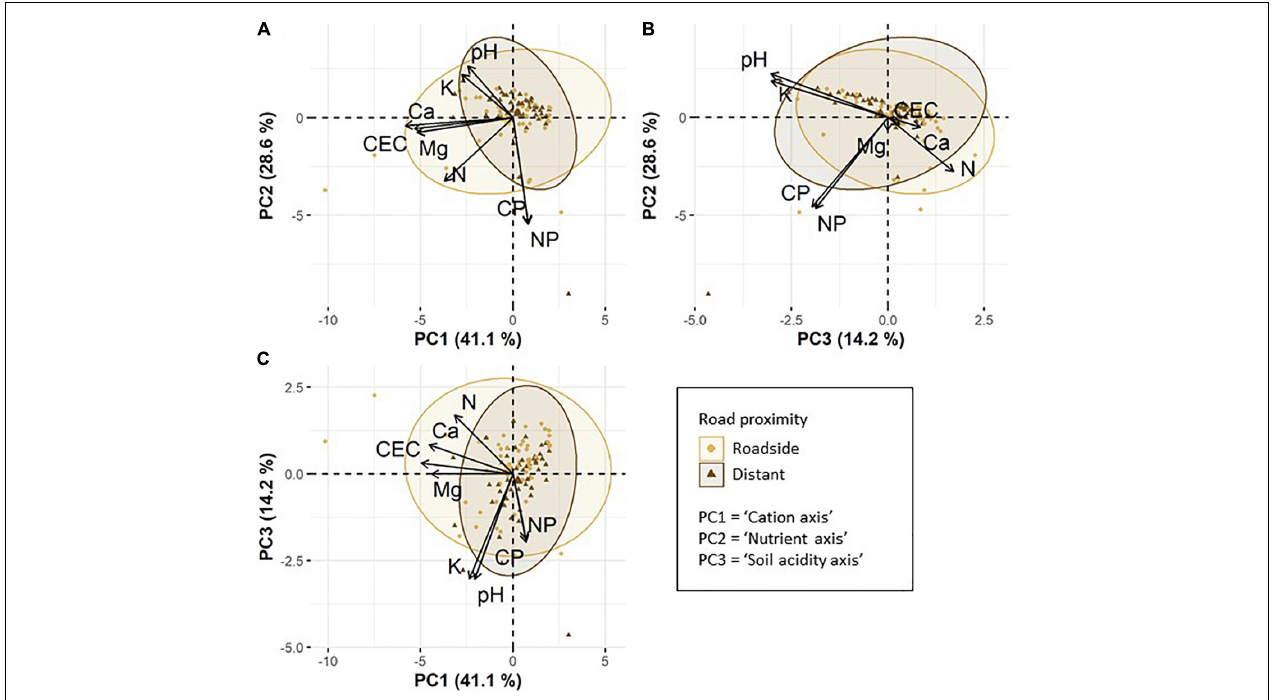
FIGURE 2 | Principle component analysis (PCA) based on eight chemical soil properties: pH, cation exchange capacity (CEC), soil nitrogen (N), carbon to phosphorus ratio (CP), nitrogen to phosphorus ratio (NP), calcium (Ca), magnesium (Mg), and potassium (K). Per cent values show the variance explained by PC1, PC2, and PC3. The ellipses are 95% confidence ellipses and visualize the variation in soil properties of roadside plots compared to distant plots. Larger symbols correspond to the ellipse centroids. (A) displays axes PC1 and PC2, (B) axes PC3 and PC 2 and (C) axes PC1 and